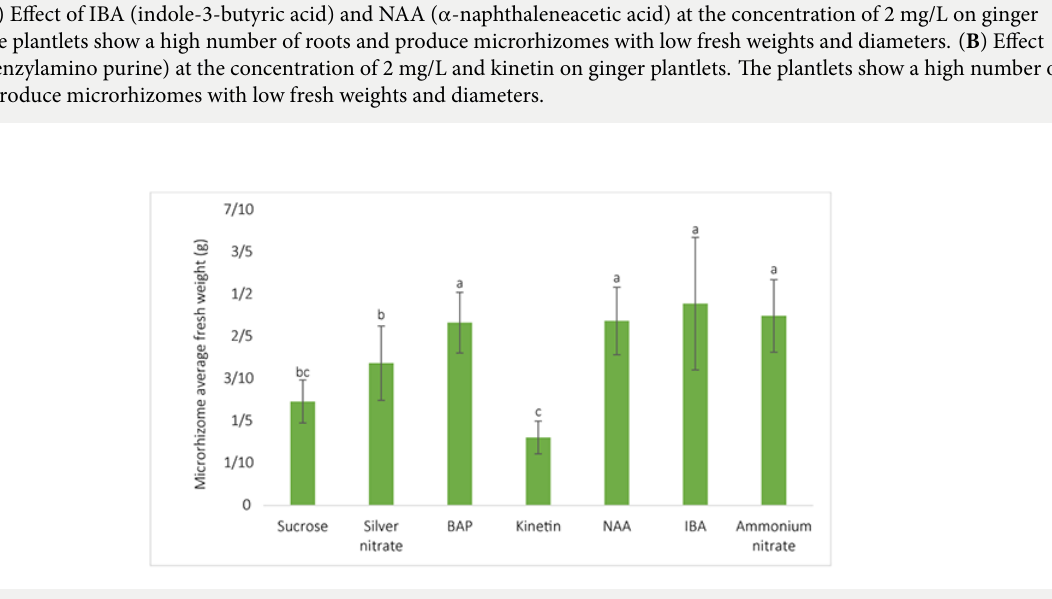
ActaAgrobotanica /2020/Volume73/Issue2/Article7329 Publisher: